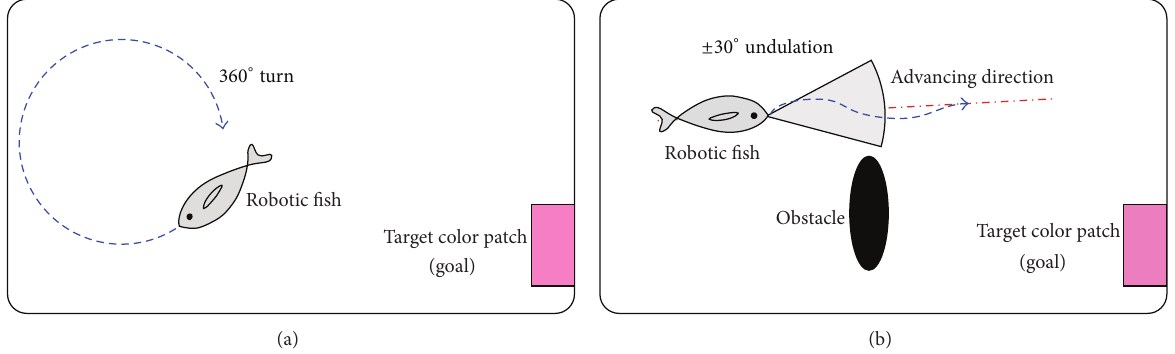
Figure 7: Two autonomous cruising strategies. (a) 360 ∘ turn. (b) ± 30 ∘ undulation.